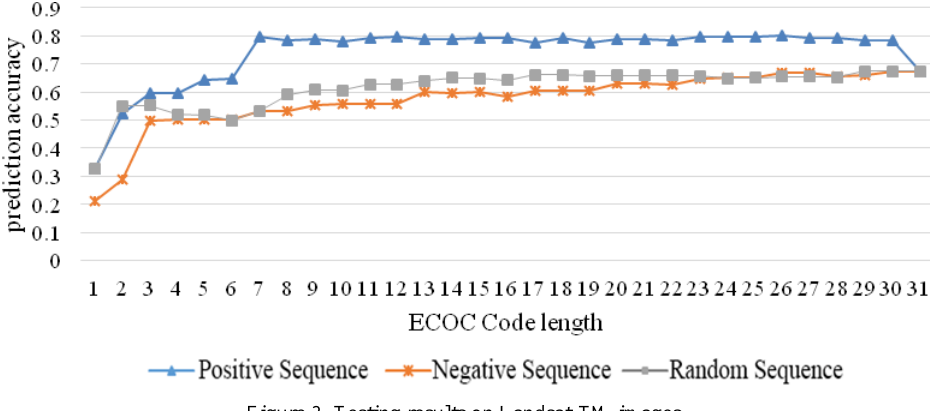
Figure 3. Testing results on Landsat-TM